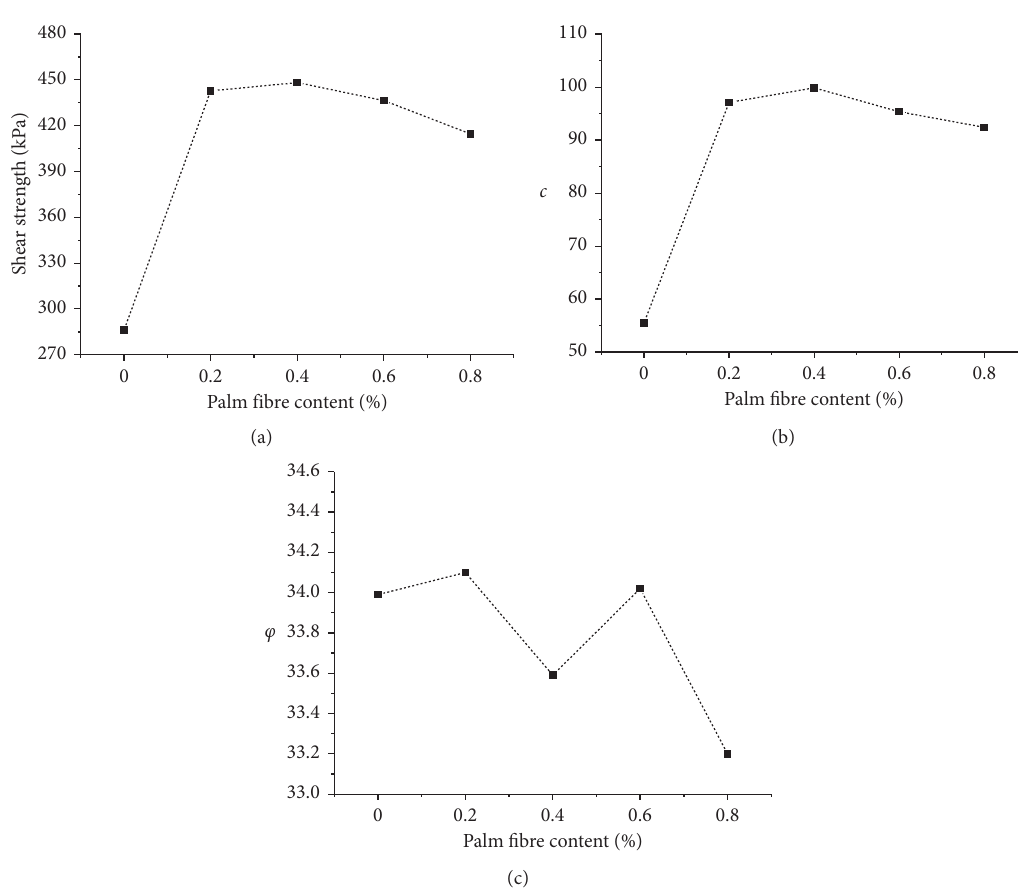
Figure 3: Mechanical parameters of substrate under different palm fibre contents. (a) Shear strength. (b) Cohesion. (c) Friction angle.